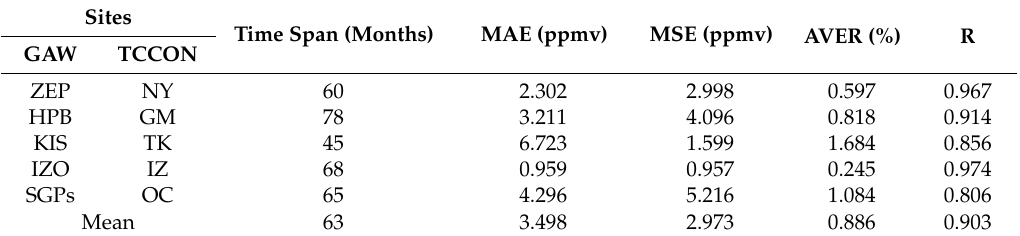
Table 6. Results between GAW and TCCON observations. The TCCON and GAW observed data are in mole fraction units: data × 10 6 = ppm in volume